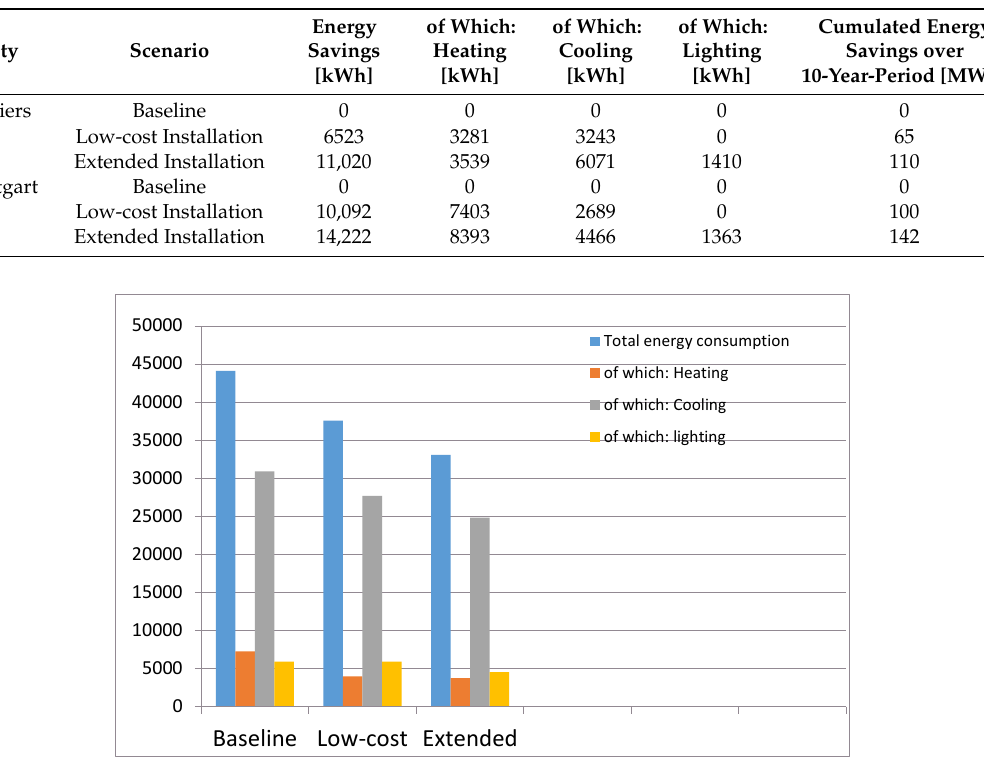
Table 5. Energy savings from home automation.